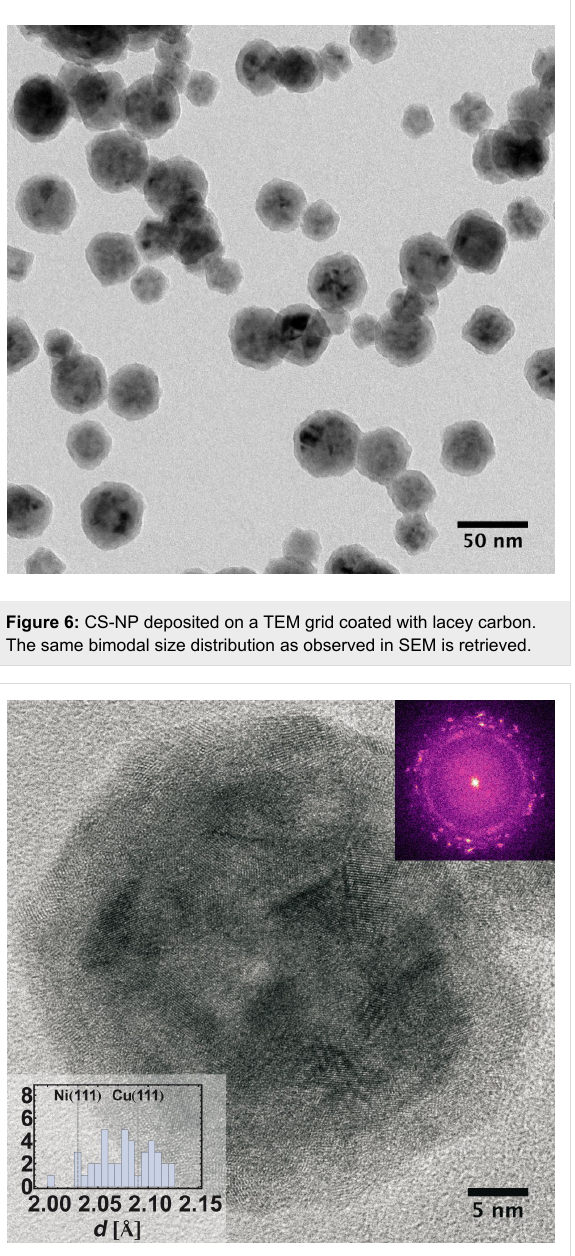
Figure 7: Single CS-NPs exhibit a polycrystalline core as confirmed by FFT analysis (inset upper right) surrounded by an oxidized layer of several nanometers thickness. All particles investigated with HRTEM are found consistent with Cu and Ni fcc phases with a slight system- atic shift towards higher values, when compared to bulk plane separa- tions (inset lower left for Cu(111) and